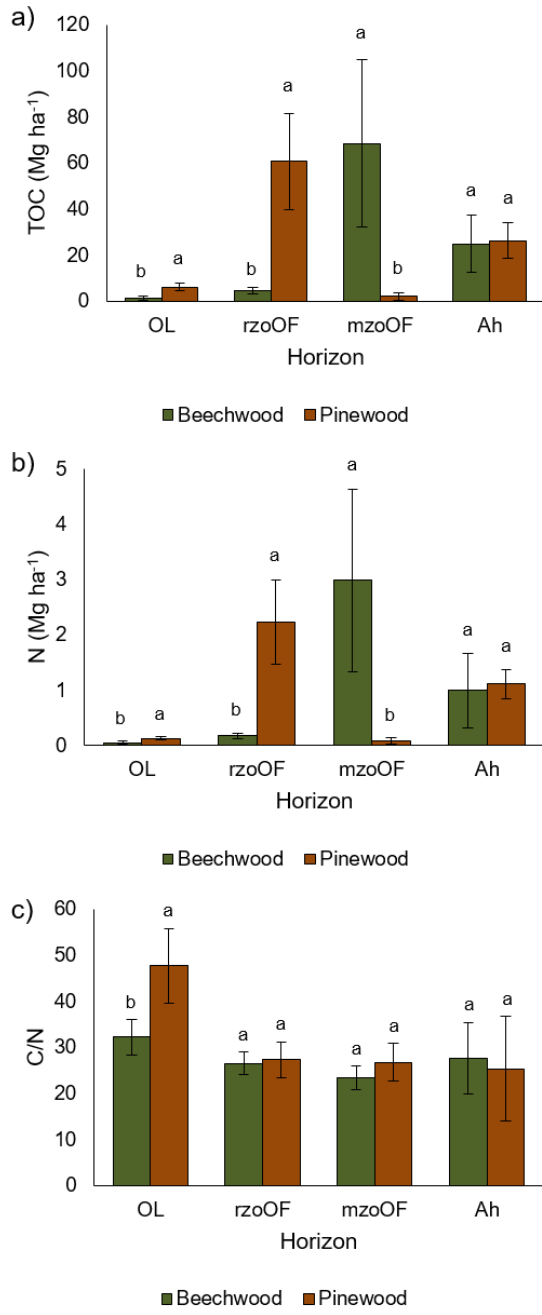
Figure 4. Total organic carbon (TOC) stocks ( a ), N stocks ( b ), and soil C/N ratios ( c ) for the observed organic layers (OL, rzoOF, mzoOF) and mineral topsoil (Ah 0–10 cm). Small letters above the bars indicate differences between forest types for each horizon at p <0.05 (ANOVA tests).